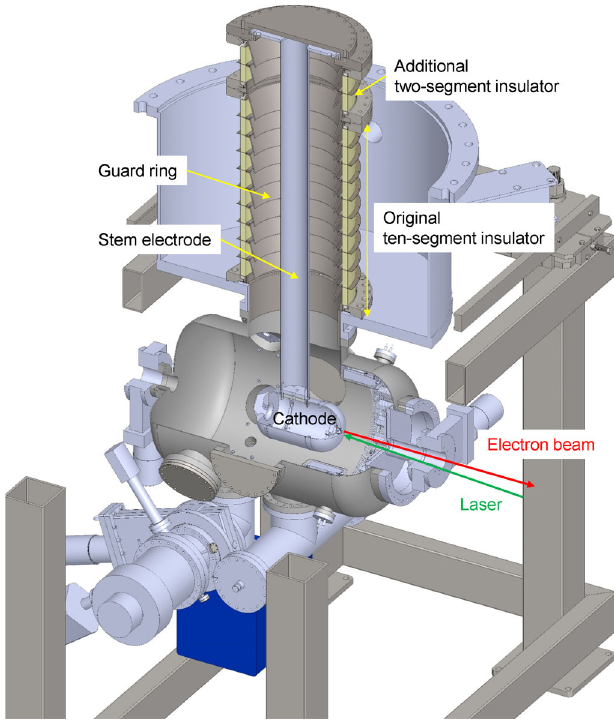
FIG. 7. Schematic illustration of the 500 kV dc photoemission gun at the cERL with additional two-segment ceramic insulator installed.